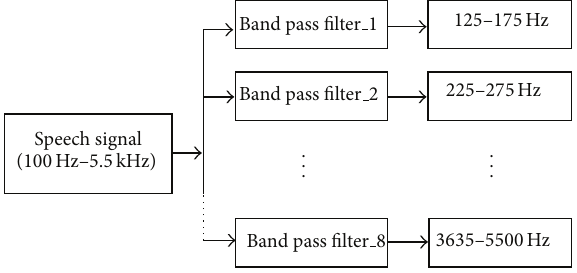
Figure 3: Filter bank for speech processor of cochlea device.